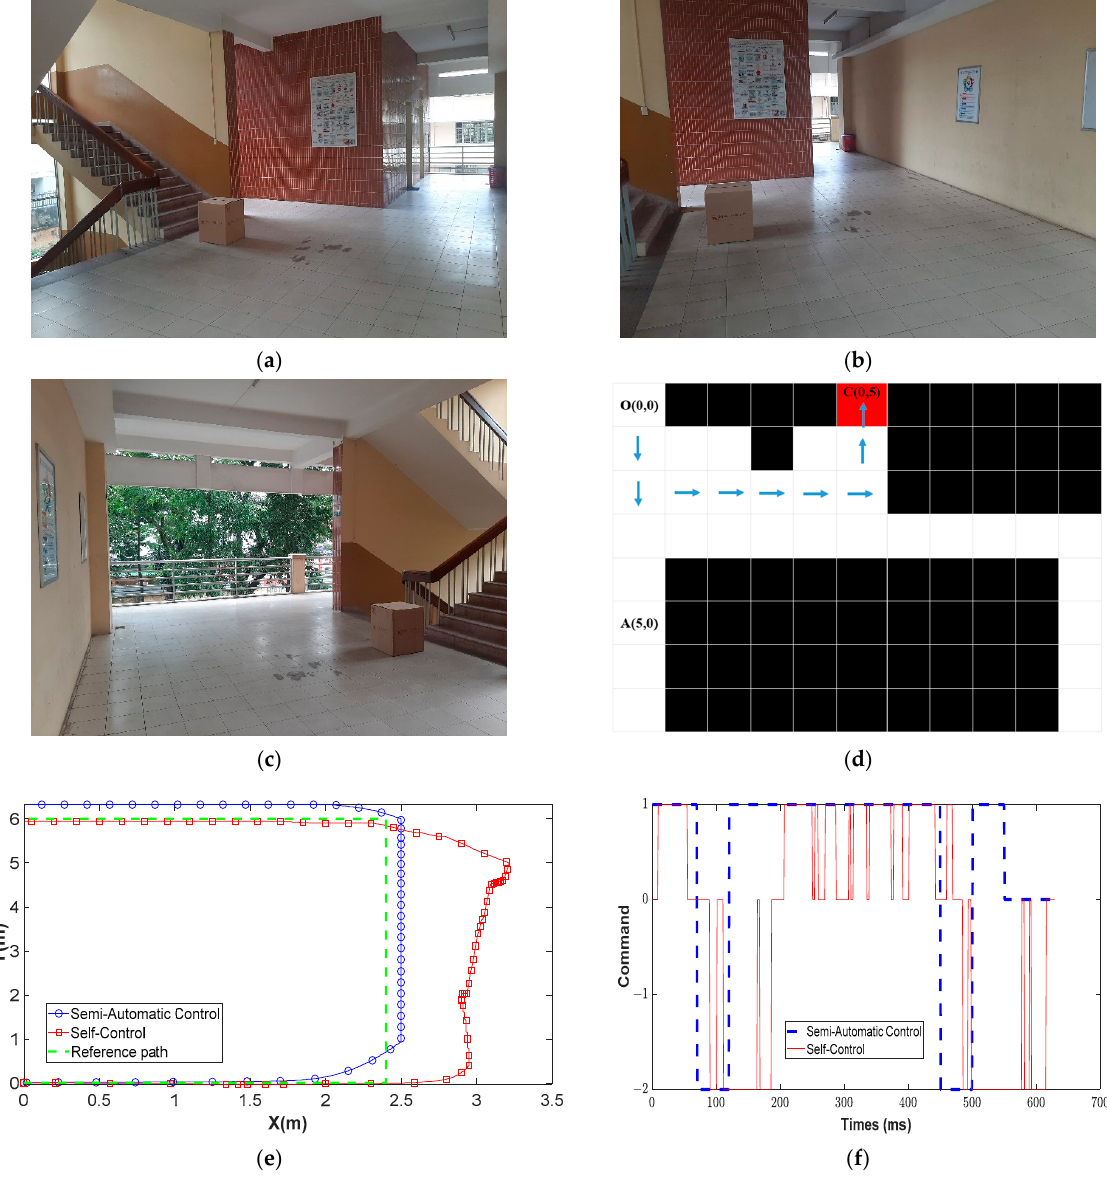
Figure 16. The comparison of the stable movements of the wheelchair in two control methods (semi ‐ automatic control and self ‐ control). ( a ) The 1st view of the real environment; ( b ) the 2nd view of the real environment; ( c ) the 3rd view of the real environment; ( d ) the blue arrow route simulated using DQNs; ( e ) the real paths of the two control methods and the reference path; ( f ) the control sequences of the two control methods.